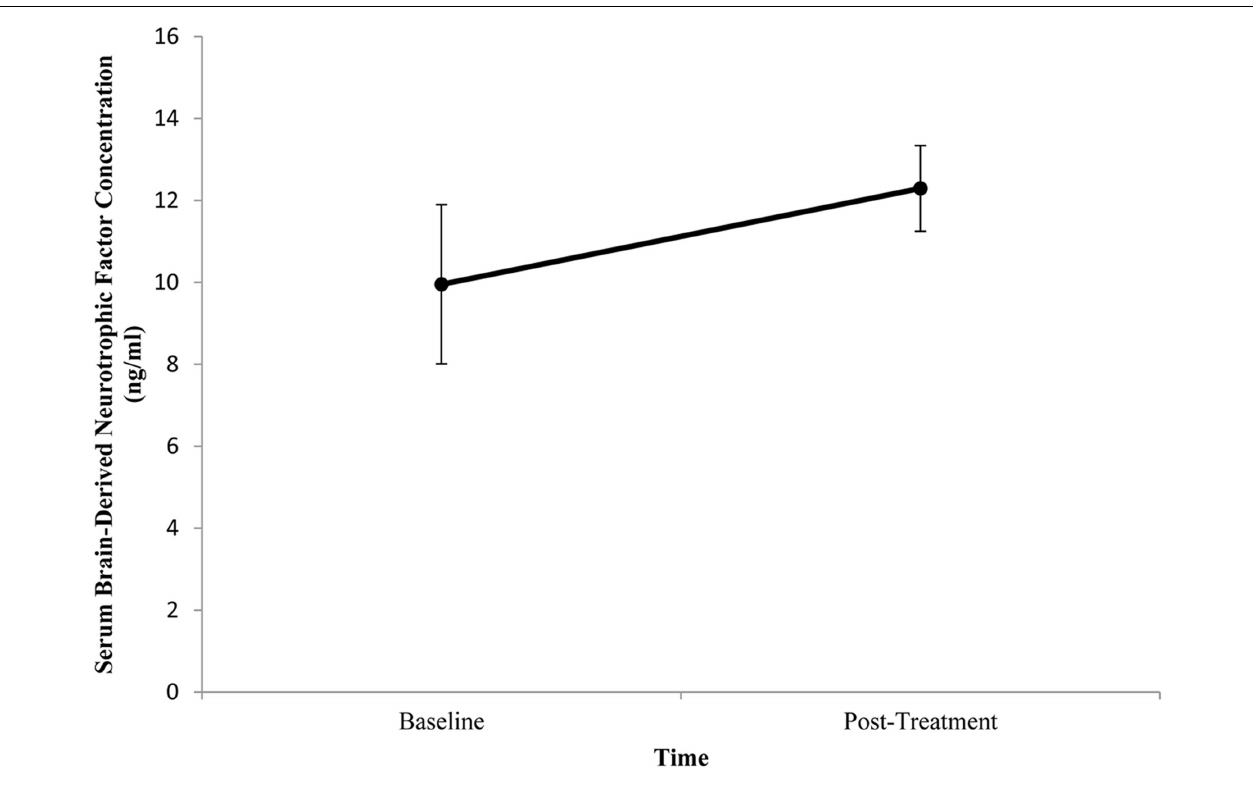
FIGURE 1 | Change in serum brain-derived neurotrophic factor (BDNF) concentration from pre- to post-treatment in patients with major depressive disorder treated with electroconvulsive therapy (ECT).